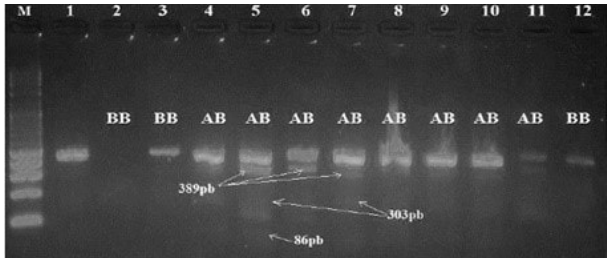
Figure 2. Gel electrophoresis of PCR products after being digested with Sau3AI restriction enzyme for detection of leptin gene poly- morphism in Tunisian cattle. Lane M: marker molecular weight 100bp DNA ladder